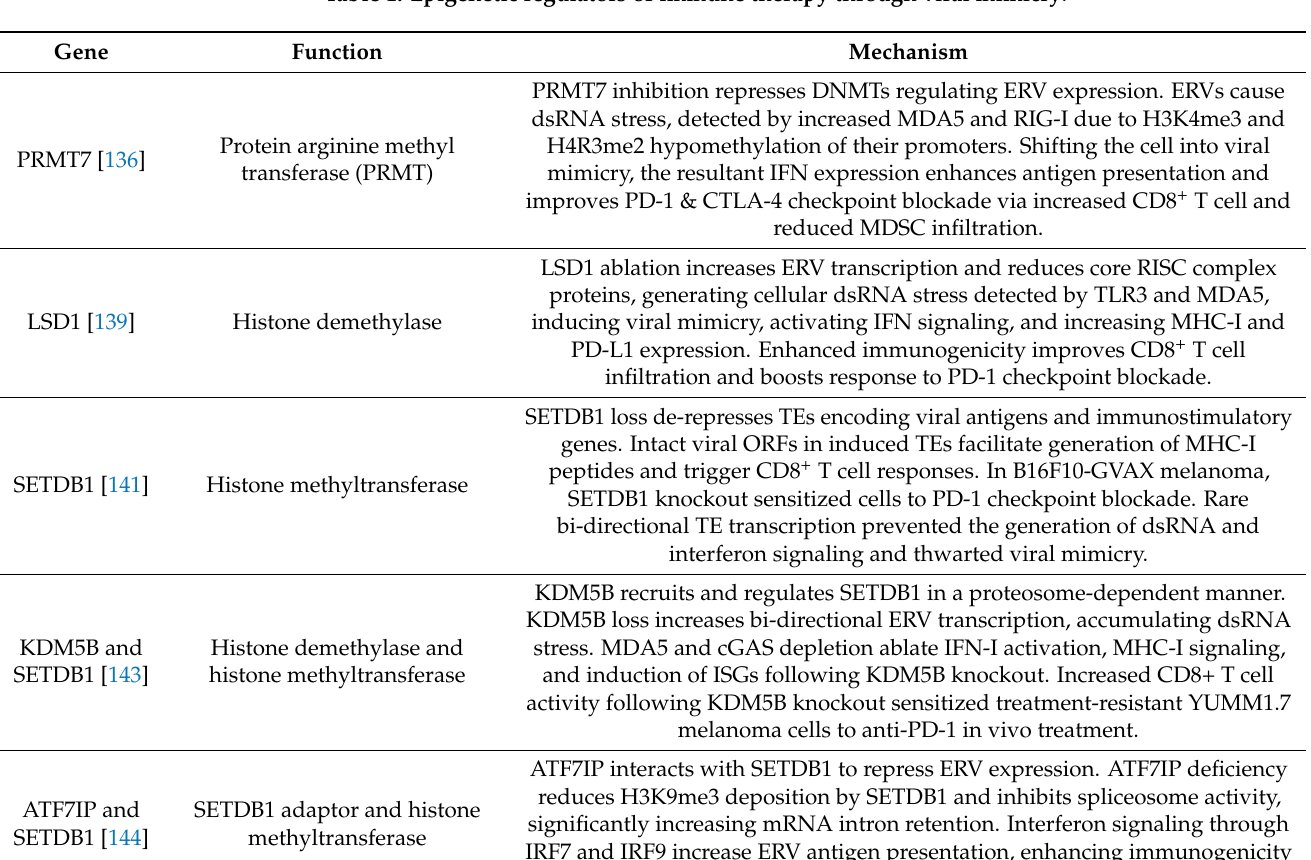
Table 1. Epigenetic regulators of immune therapy through viral mimicry